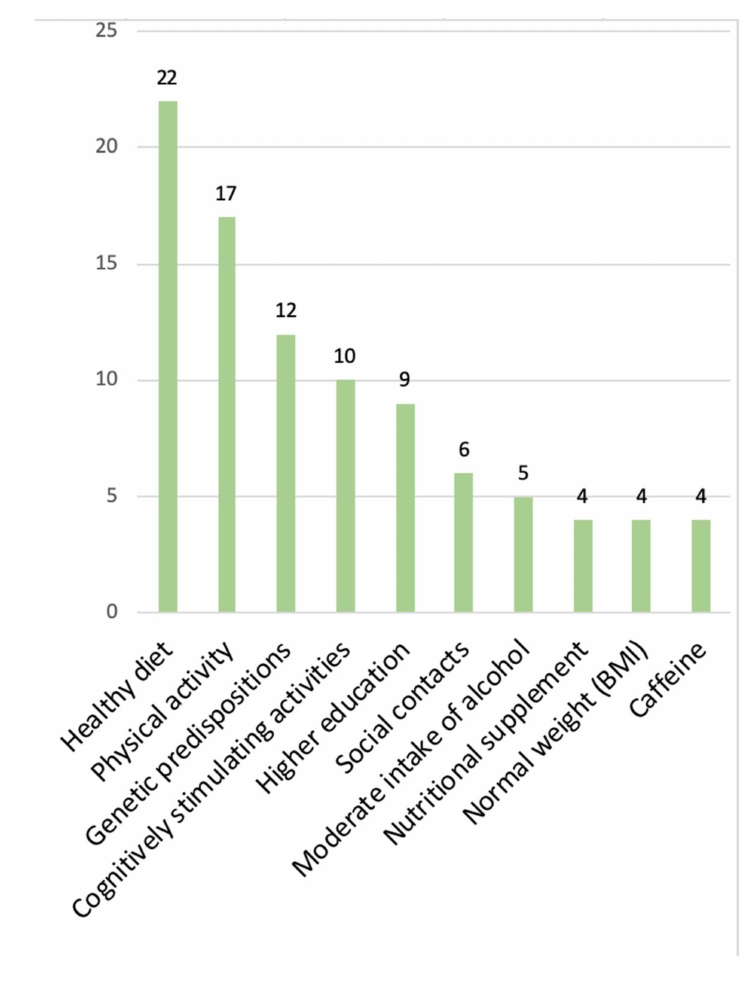
Figure 6. The most frequently studied protective